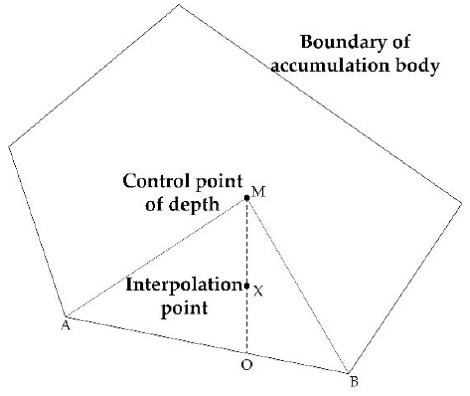
Figure 5. Depth calculation in Delaunay